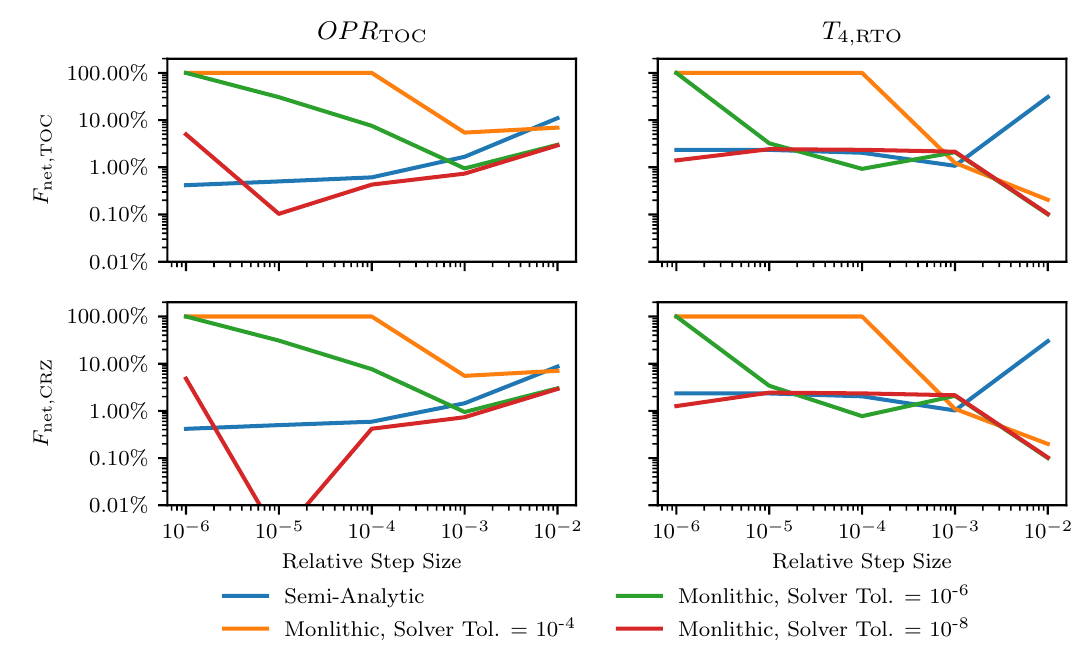
Figure 9. Net thrust total derivative error for semi-analytic and monolithic